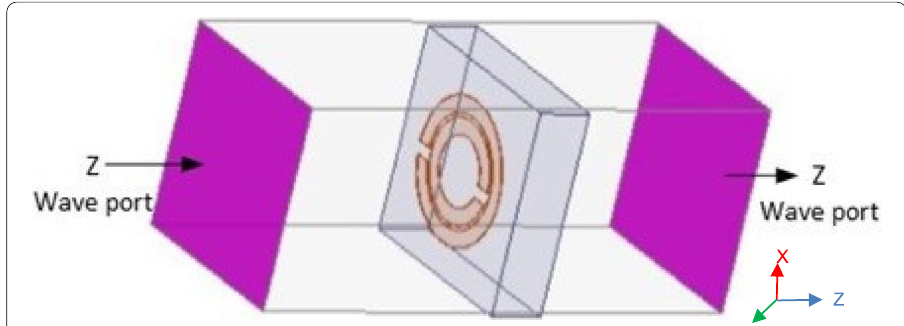
Fig. 6 Simulation model of unit cell of SRR (Unit cell boundary conditions are applied along x and y direction and wave ports are applied in z direction)